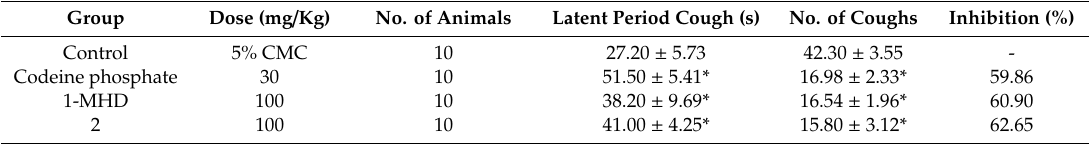
Table 1. Effects of different drug on the ammonia liquor induced cough in mice. Table 1. E ff ects of di ff erent drug on the ammonia liquor induced cough in mice.